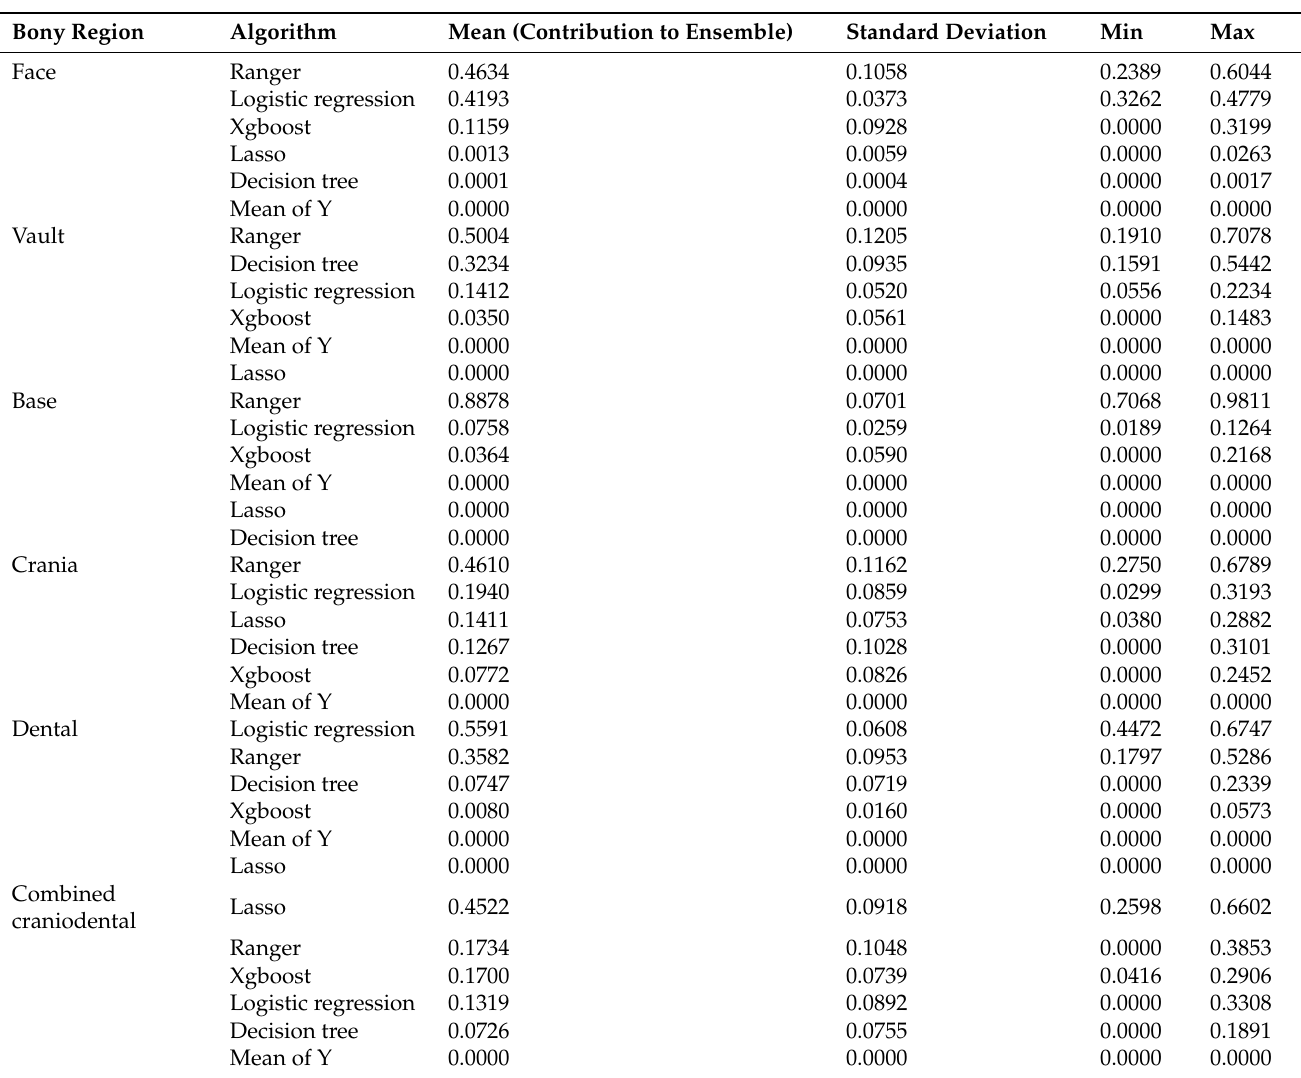
Table 6. Algorithm weight contributions to the SuperLearner